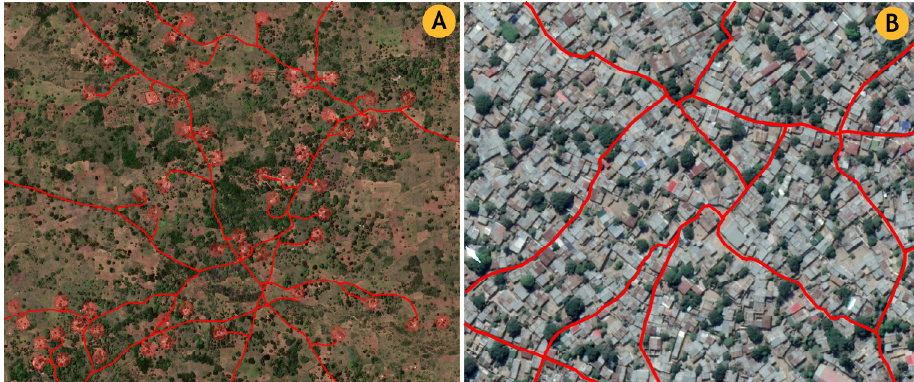
Figure 5. Transition from rural setting to informal settlement (source: created by the authors using Google Earth (2018) aerial photography). Legend: ( A )—routes, plots and buildings within the rural fabric; ( B )—routes, plots and buildings within the informal fabric.